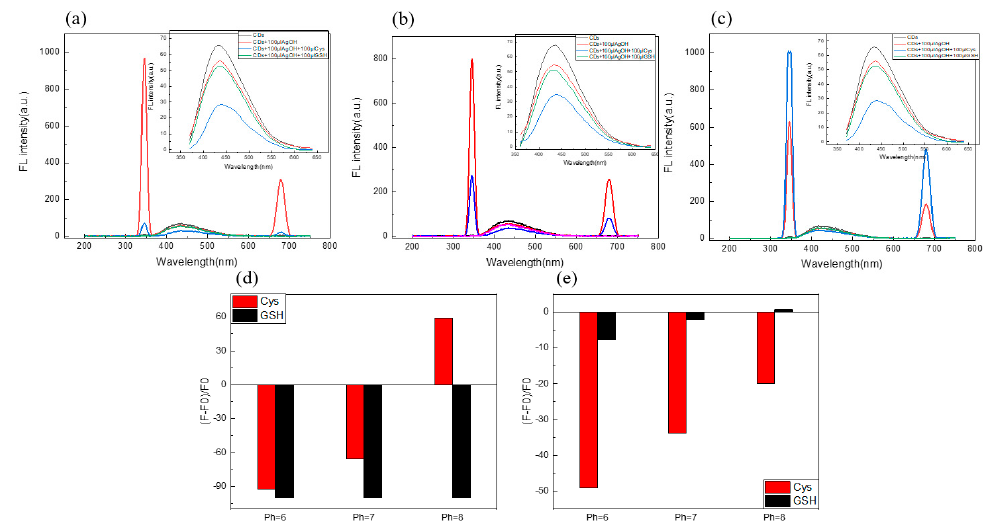
Figure 5. ( a ) The e ff ect of pH (6.0 ( a ), 7.0 ( b ), 8.0 ( c ), Phosphate bu ff er solution) on the intensity of both the RLS and FL of the C / N-dots–Ag + complex system by adding Cys and GSH; the insets corresponded to FL changes; the corresponding columnar changes of fluorescence intensity ( d ) and RLS intensity ( e